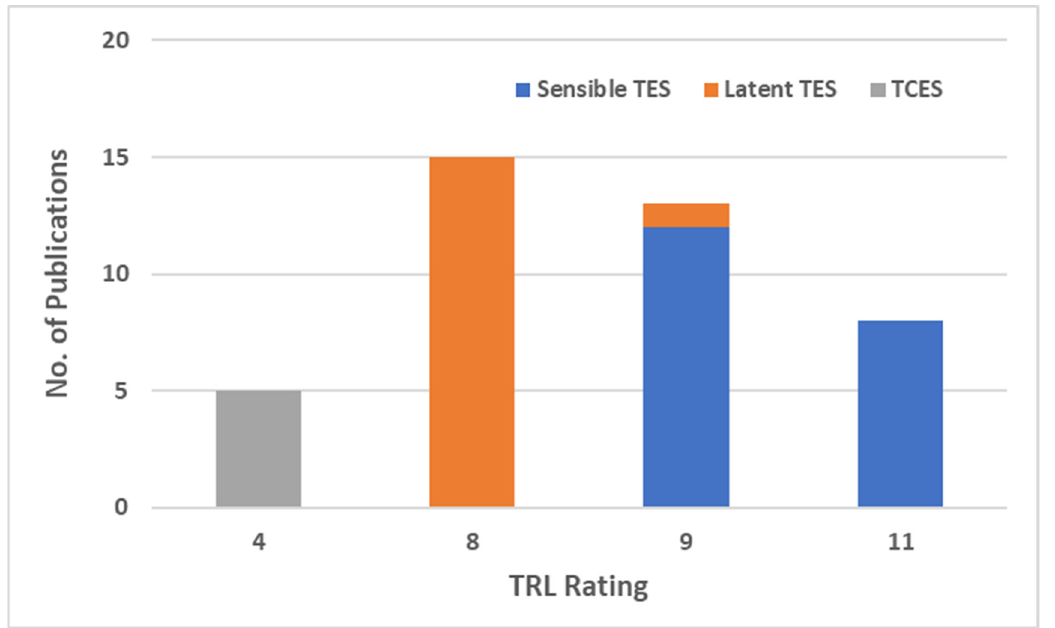
Figure 7. TRL rating of TES assessed in LCA publications for building and district applications.